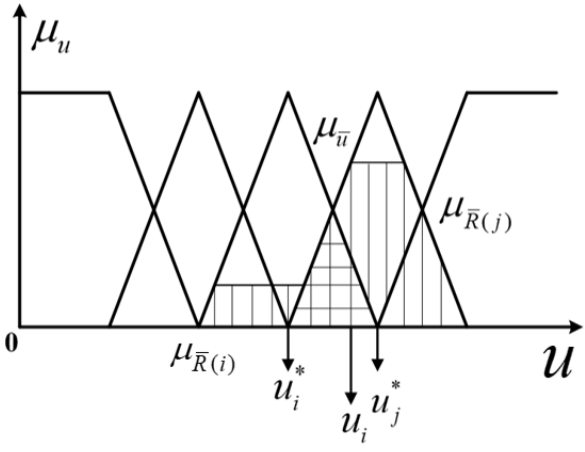
Figure 10. Operating principle of center of gravity method. Table 1. The fuzzy logic